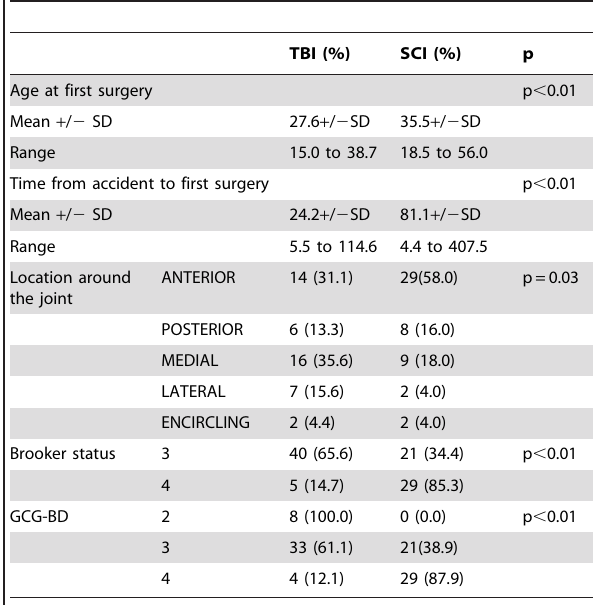
Table 2. Comparability between the two groups: TBI versus